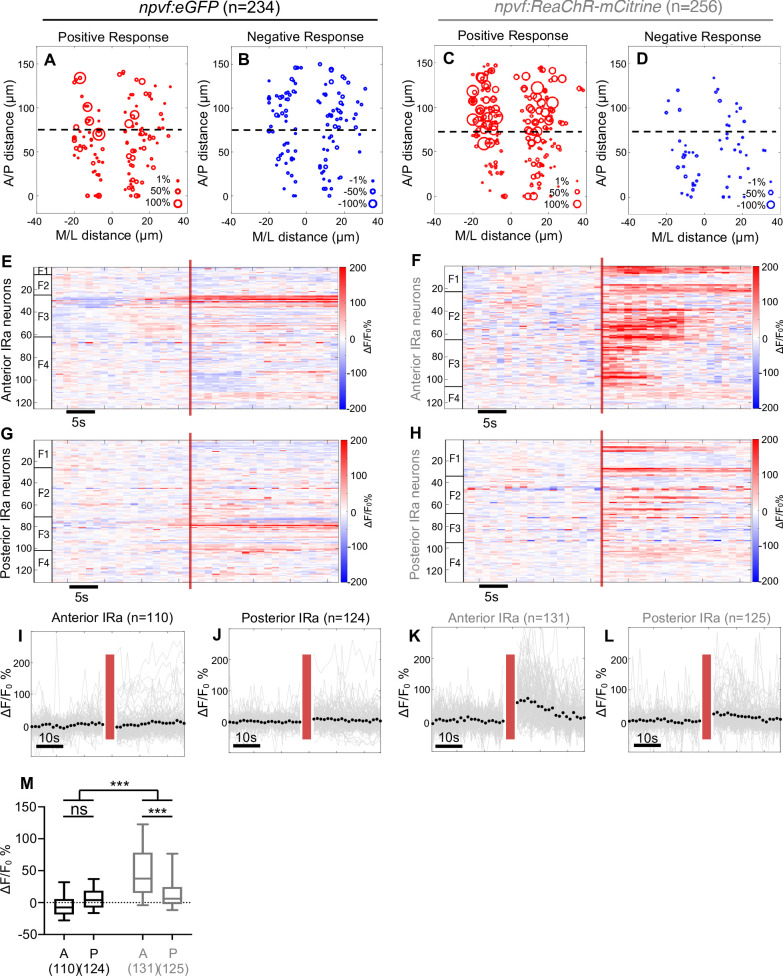
Optogenetic stimulation of NPVF neurons activates anterior IRa neurons.(A,B) 6-dpf Tg(npvf:eGFP); Tg(npvf:GCaMP6s-P2A-tdTomato) and (C,D) Tg(npvf:ReaChR-mCitrine); Tg(npvf:GCaMP6s-P2A-tdTomato) animals were analyzed for normalized GCaMP6s fluorescence in IRa neurons before and after optogenetic stimulation of NPVF neurons. Positive (red) or negative (blue) normalized GCaMP6s fluorescence responses of individual IRa neurons is plotted according to their spatial location along the anterior/posterior and medial/lateral axes of the brain. The size of red or blue circles indicates the magnitude of increase or decrease of normalized GCaMP6s fluorescence, respectively. The horizontal dashed line indicates division of the IRa into anterior and posterior halves. A, anterior; P, posterior; L, lateral; M, medial. ‘0’ along the A/P axis indicates location of the most posterior IRa neurons. ‘0’ along the M/L axis indicates the midline of the IRa neuron population. (E–L) Normalized GCaMP6s fluorescence of individual neurons in the anterior or posterior halves of the IRa shown as heat maps (E–H), in which each horizontal line represents an IRa neuron, and as line graphs (I–L) showing individual (gray lines) and mean (dotted line) IRa neuron responses before and after optogenetic stimulation (red lines) in Tg(npvf:eGFP); Tg(tph2:GCaMP6s-P2A-tdTomato) (E,G,I,J) and Tg(npvf:ReaChR-mCitrine); Tg(tph2:GCaMP6s-P2A-tdTomato) (F,H,K,L) animals. F1-F4 in (E–H) indicate neurons from four different fish. (M) Box plot of normalized GCaMP6s ΔF/F0 % values in anterior or posterior IRa neurons averaged for the first 10 imaging frames after stimulation of NPVF neurons in Tg(npvf:eGFP); Tg(tph2:GCaMP6s-P2A-tdTomato) (black) and Tg(npvf:ReaChR-mCitrine); Tg(npvf:GCaMP6s-P2A-tdTomato) (gray) animals. n = number of neurons quantified from four animals of each genotype. ***p<0.001, Two-way ANOVA, Holm-Sidak test.